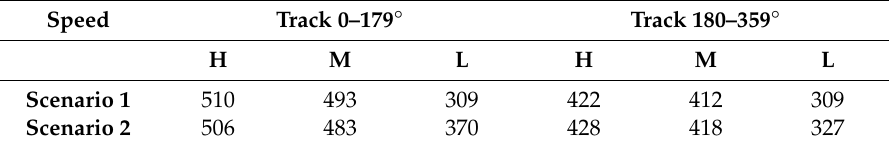
Table 7. Average speeds for each wake vortex class and semicircular cruising level